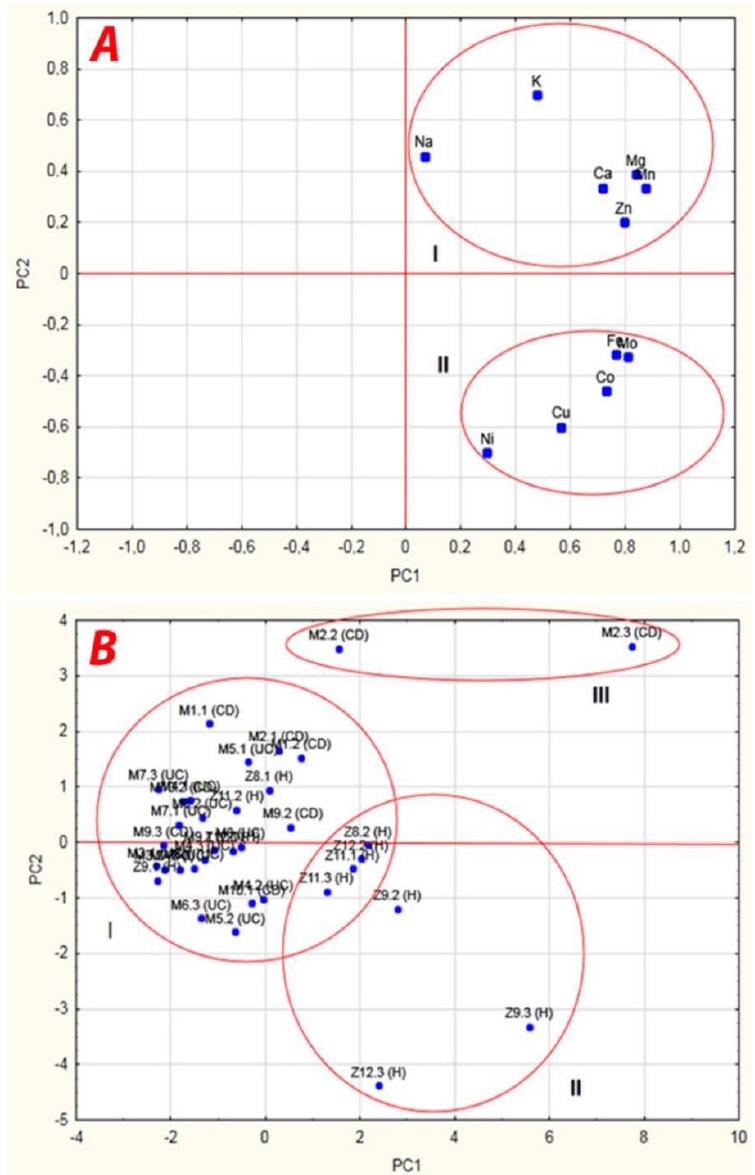
Figure 3. Loading ( A ) and score ( B ) plots of the PCA for samples from patients with IBD. Note: designation of SRB strains as in Table 1; UC indicates ulcerative colitis, CD indicates Crohn’s disease, and H indicates a healthy person.